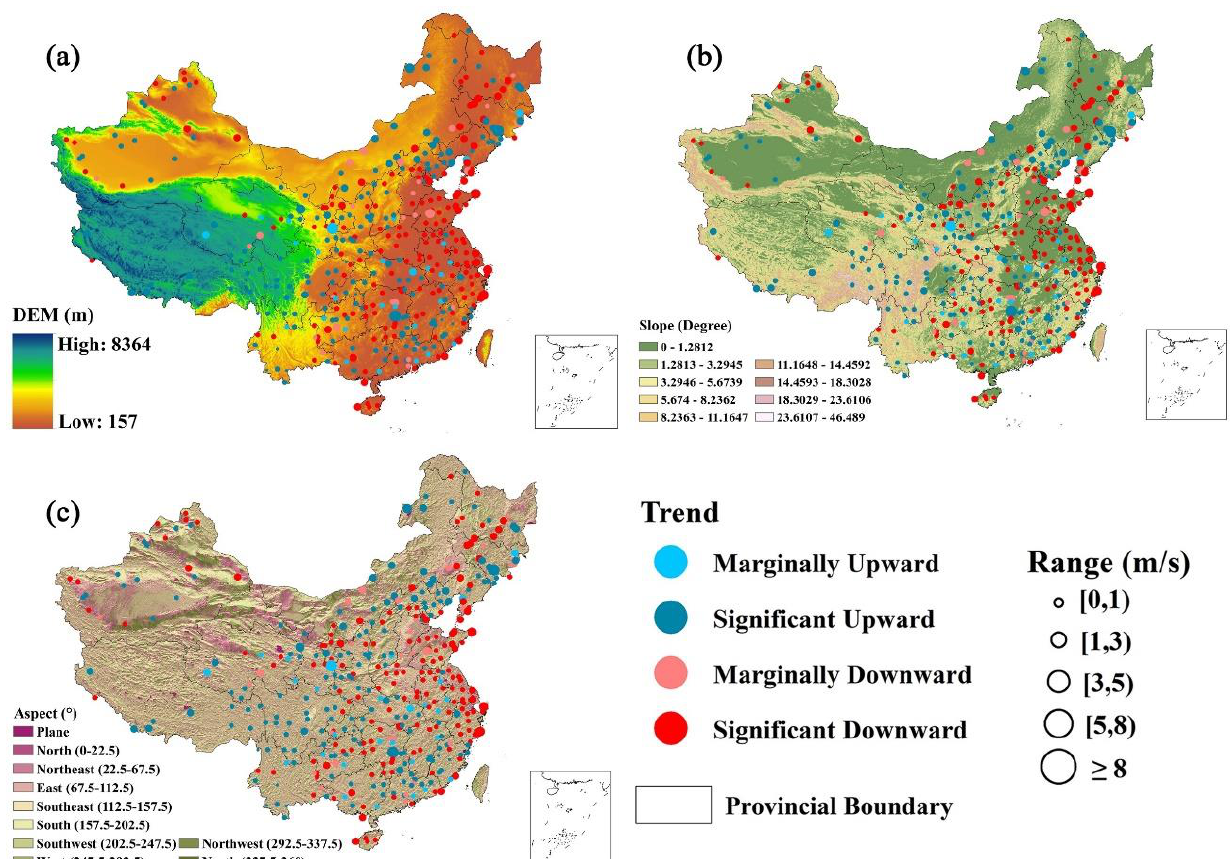
Figure 9. Spatial distribution of different wind speed changes from 2000 to 2019 over the ( a ) DEM; ( b ) slope; ( c ) aspect of China.